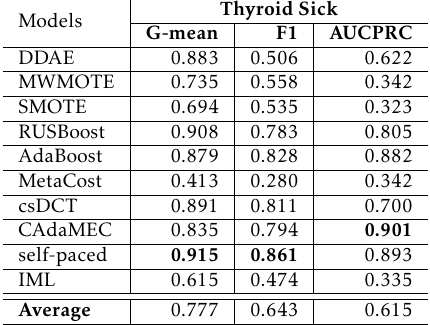
Table 8. Overall Results for Thyroid Sick Dataset